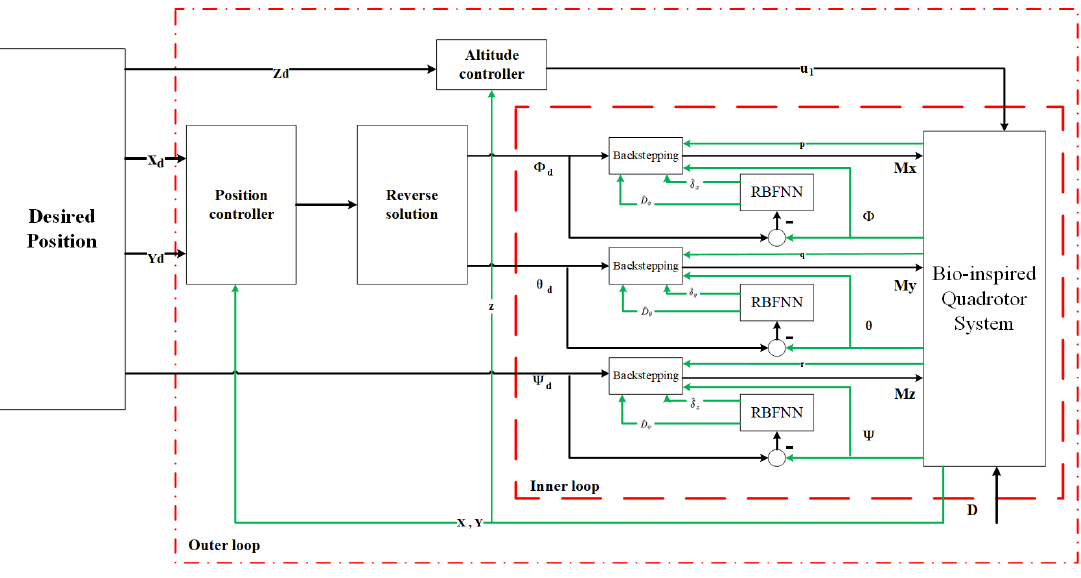
Figure 5. The control block diagram of the proposed